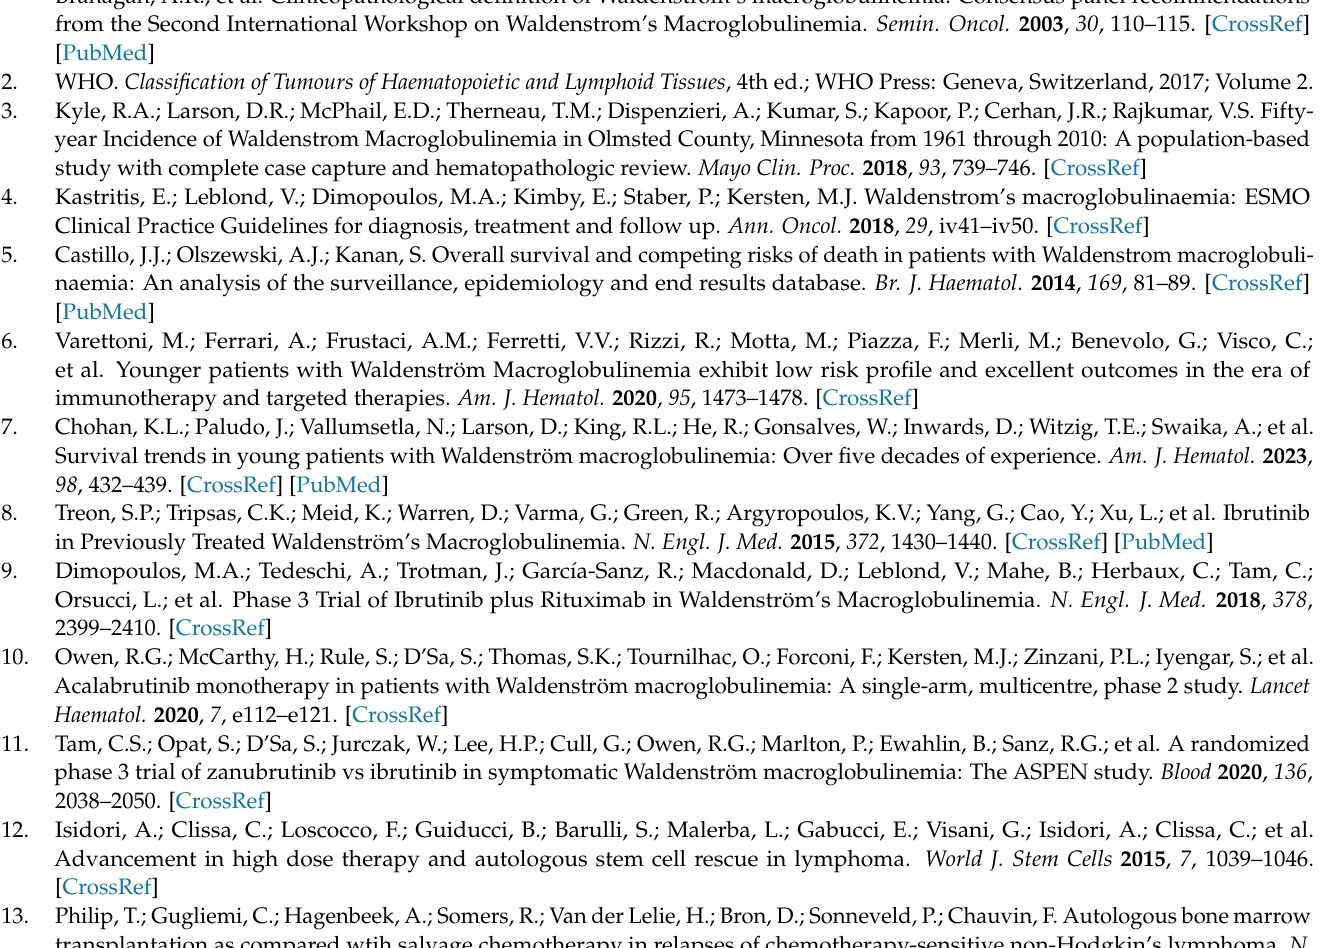
Table S2: Toxicities according to